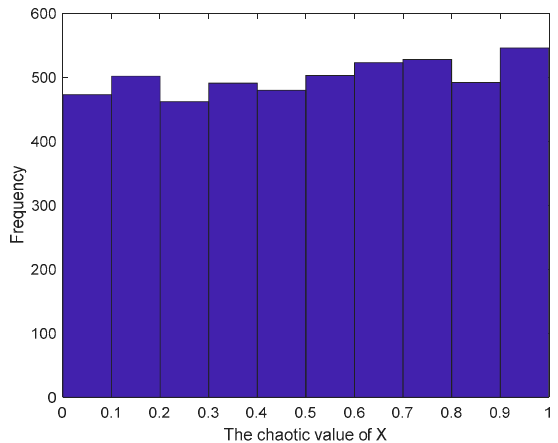
Figure 5. Improved logistic chaos value histogram.